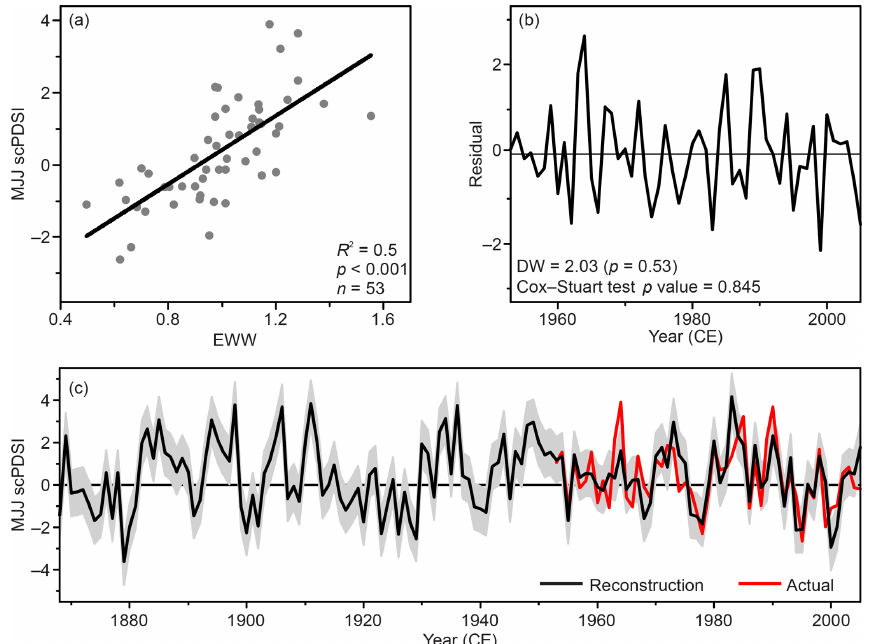
Figure 6. MJJ scPDSI reconstruction using NELR-based EWW STD chronology. (a) Scatter diagram for the period 1953–2005 and (b) the resulting residuals. (c) MJJ scPDSI reconstruction (black line, after variance adjusted) and instrumental MJJ scPDSI (red line). Shaded area denotes the uncertainties of reconstruction in the form of ± 1 root-mean-square error. Table 3. Statistics of regression models for split calibration–verification periods. Calibration period